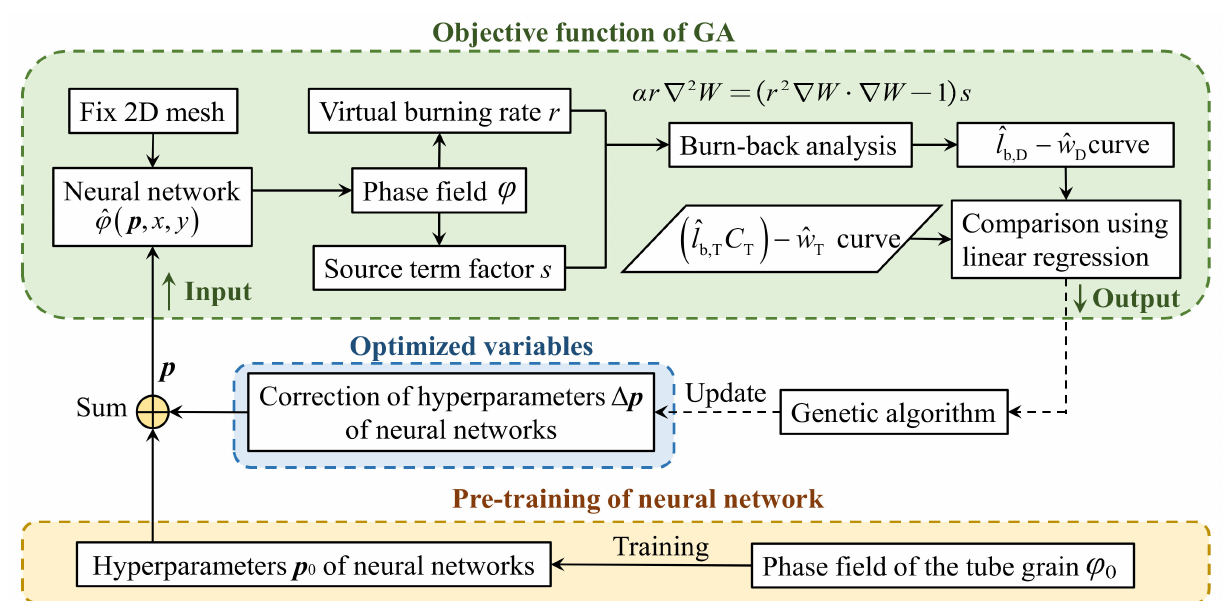
Figure 13. Genetic algorithm